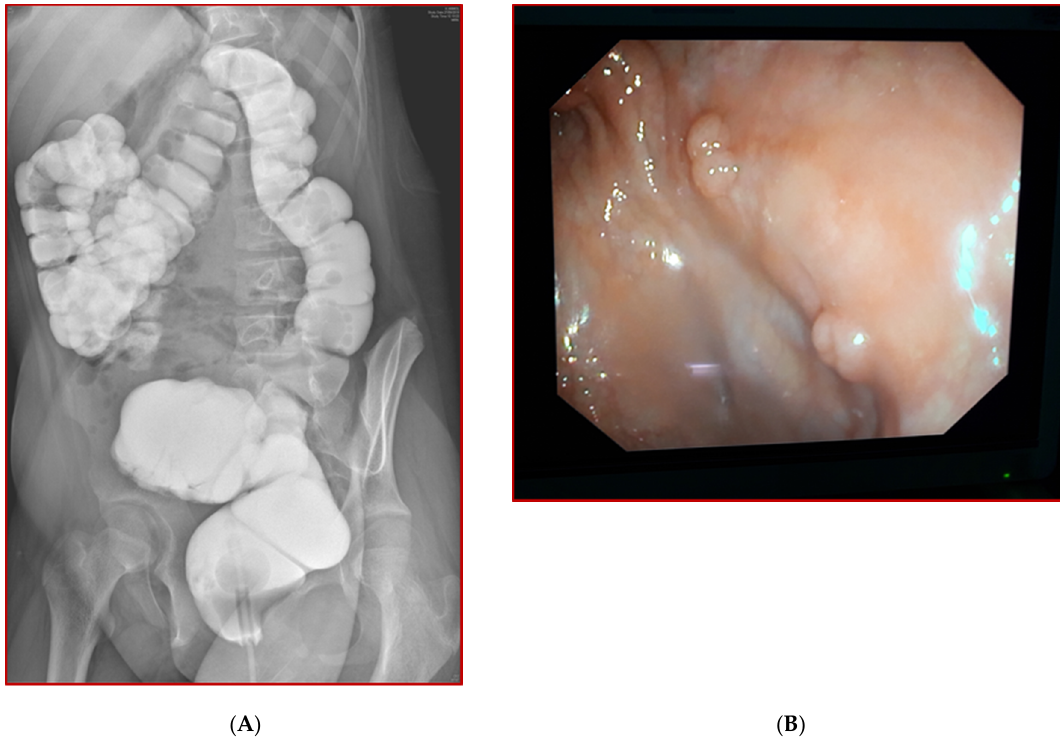
Figure 8. Barium enema ( A ) and endoscopy ( B ) examinations during follow after Cologne pouch intervention. There were no post-operative complications and the patient was discharged in good con-